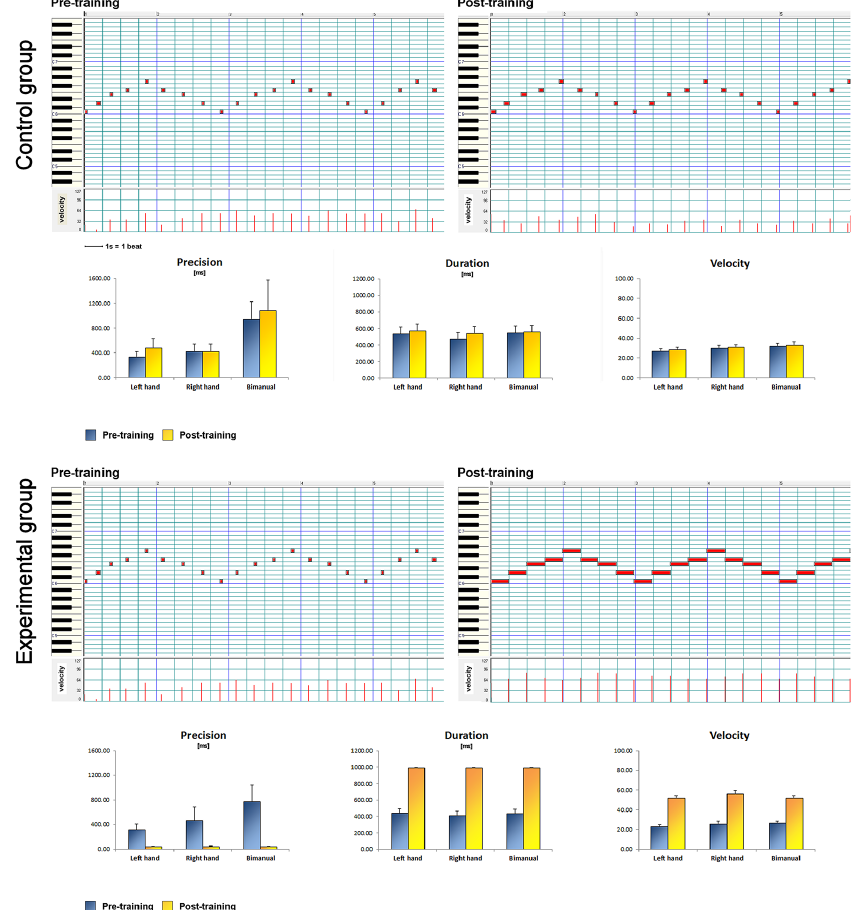
Fig 2. MIDI data. For each group, the piano-roll representation of the first 5 bars of the piano sequence played by a subject in the “ pre ” (left) and “ post ” (right) condition is displayed, on top of the figure. Blocks within the piano-roll show the played note (i.e. vertical position: each horizontal line represents a note, see the piano keyboard displayed on the left as a reference) and their duration (i.e. horizontal width of the block: vertical lines represent quarters within bars, the space between two vertical lines is a quarter). On the lower section of the piano-roll tables, velocities of each played note are shown. The experimental group played in a more “ staccato ” , soft and imprecise way before training, while a more “ legato ” , firm and precise style was obtained after 10 days of training. Below these graphs are represented the precision, duration and velocity as mean values + standard errors in the “ pre ” and “ post ”